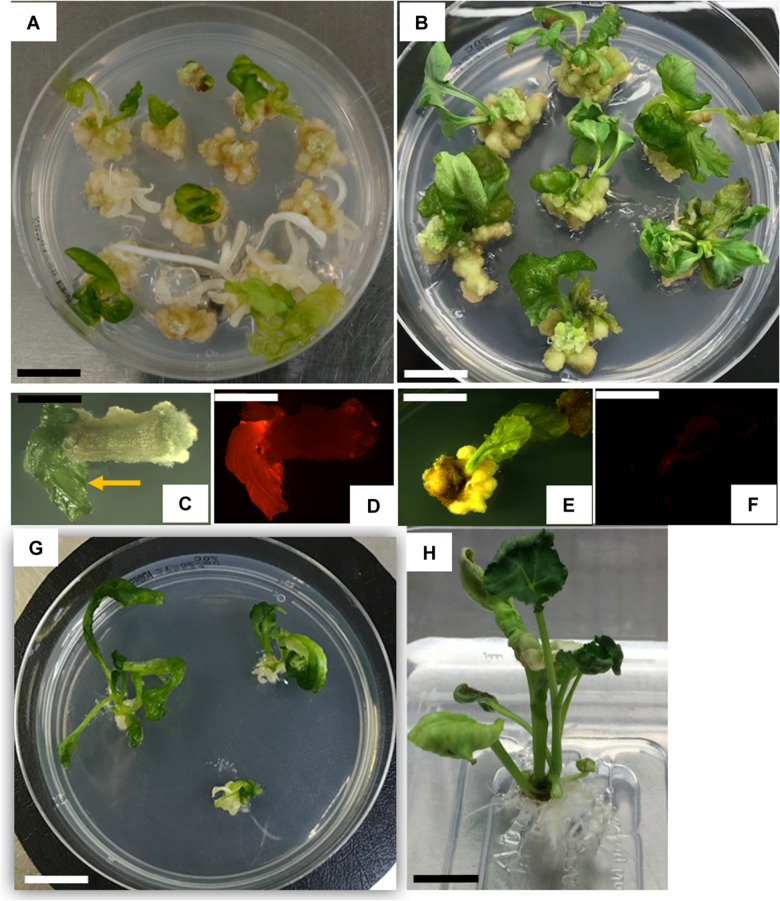
Canola transformation. (A) Transgenic (green) and non-transgenic (bleached) shoots at 31 days after infection; (B) wild-type internodal tissue culture with no selection at 31 days (C,D) transgenic shoot, brightfield (C), and corresponding shoot expressing TagRFP (D); (E,F) wild-type shoot, brightfield (E) and corresponding auto-fluorescent view (F); (G) elongating shoots at 42 days after infection; (H) transgenic rooted plant. Scale bar for A,B,G,H = 1.0 cm; scale bar for C–F = 0.4 cm.